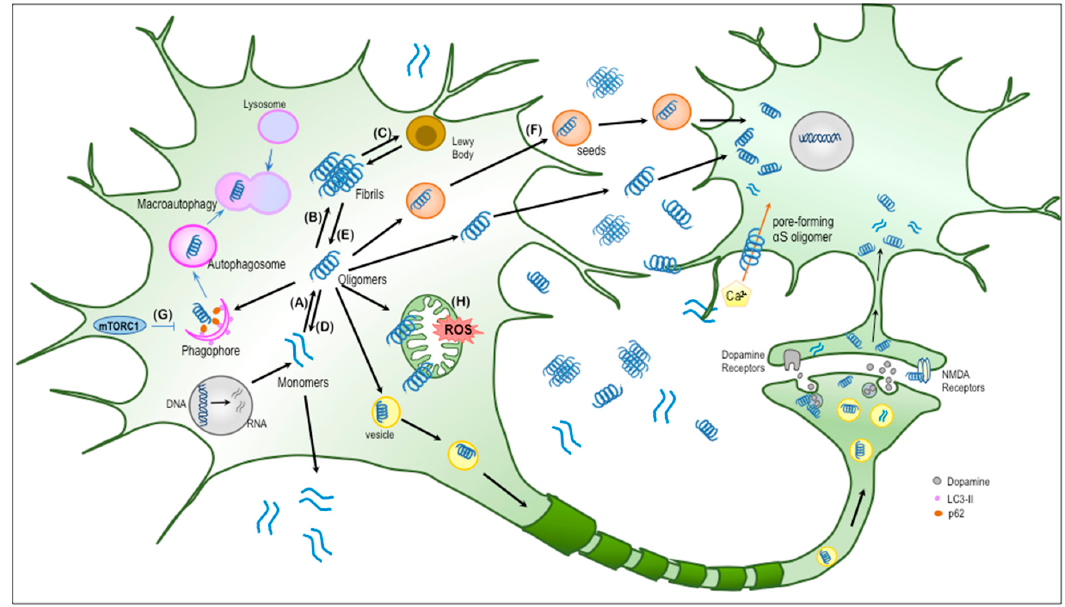
Figure 1. The main effects of natural phenolic compounds modulating α S aggregates. ( A , B ) Inhibiting the oligomerization and fibrillization of α S, ( C ) preventing the accumulation of α S fibrils, ( D , E ) promoting the degradation of α S fibrils, ( F ) preventing the seeding and transfer of α S from cell to cell, ( G ) downregulating mTORC1 (mammalian target of rapamycin complex 1) signaling and recovering suppressed macroautophagy, and ( H ) reducing ROS (reactive oxygen species)